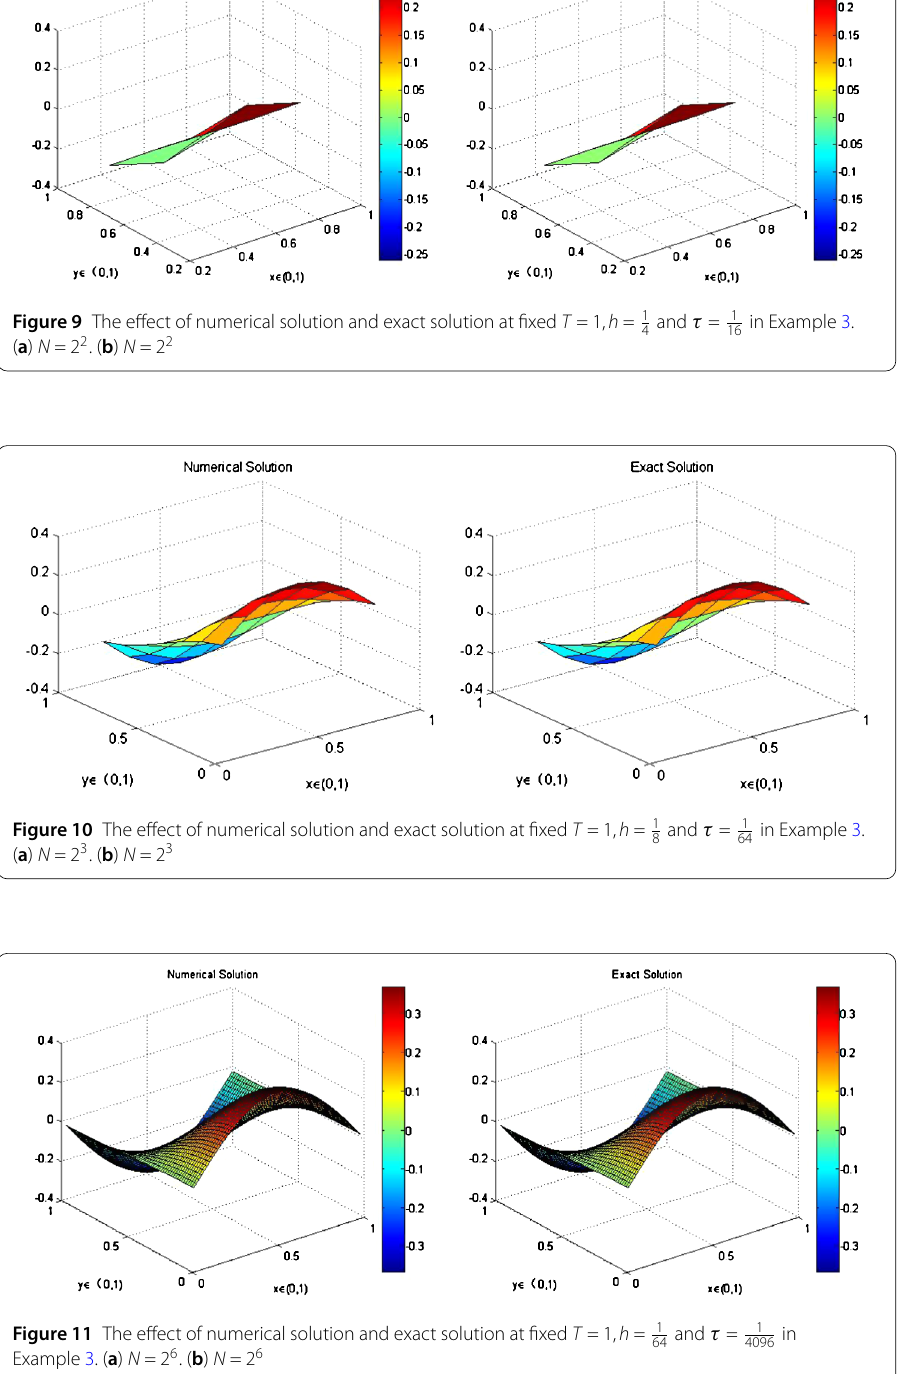
and τ = 1 in 64 4096